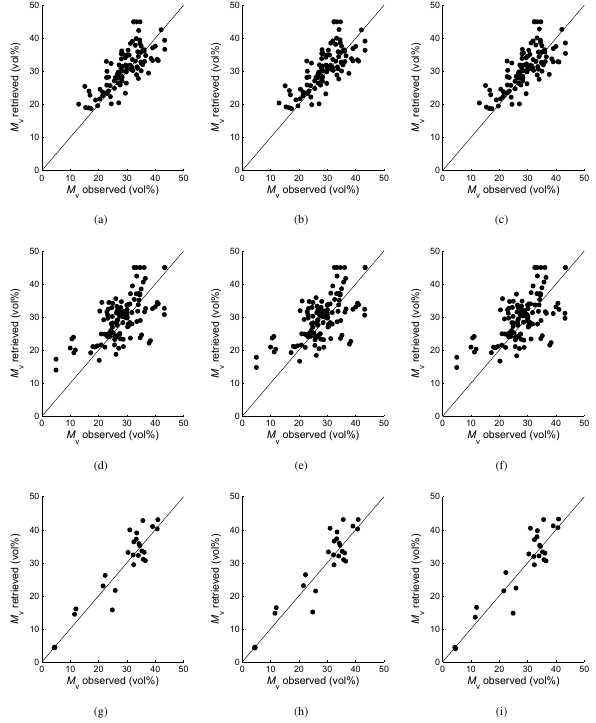
Fig. 12. Retrieved versus observed in situ soil moisture based on the cross-validation for strategy 1 (left), strategy2(middle)andstrategy3(right),usingC-bandHH(top),C-bandVV(middle)andL-bandHH(bottom) configuration.